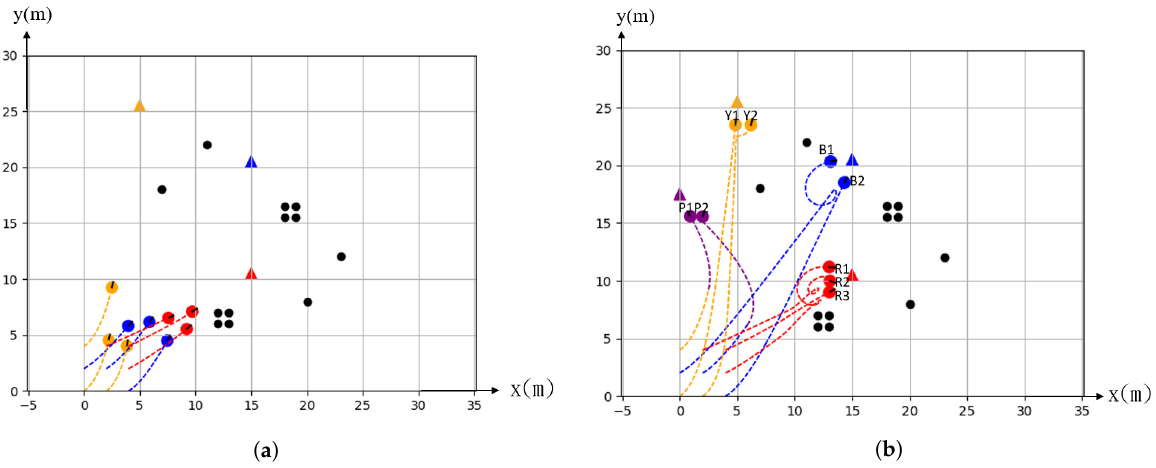
Figure 7. Simulation of increasing target. ( a ) Original toward to the target. ( b ) Finally stop at the each target. Figure 8 target disappeared during the movement after 40 iterations of time steps. It turned out that the red group was split shows the simulation in decreasing a target. Four targets in terms of red, yellow, blue and purple colors and denoted with triangle symbols that appeared initially. A fleet of nine agent launched from the starting position and was demanded to move toward targets as four subgroups as shown in Figure 8a. We tentatively set that the red and joint to other groups that were approaching to the blue and yellow targets, respectively, as shown in Figure